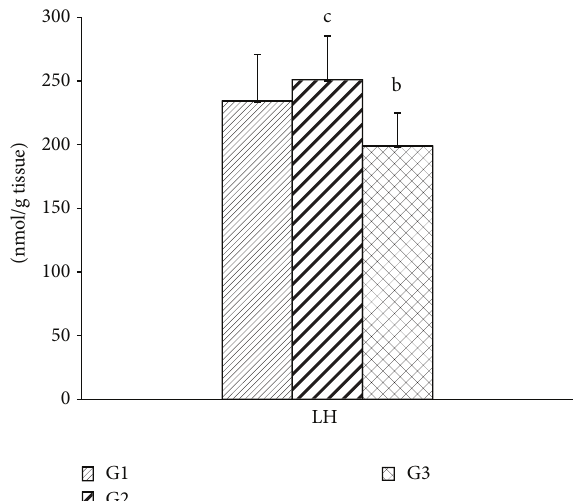
Figure 4: Hepatic lipid hydroperoxide levels after 30 days for all experimental groups. Values are given as the mean ± SD for each group of eight animals. a Significantly different from G1; 𝑃 ≤ 0.05 ; b significantly different from G2; 𝑃 ≤ 0.05 ; and c significantly different from G3; 𝑃 ≤ 0.05 . G1: untreated control; G2: treated with geraniol; and G3: treated with essential oil.